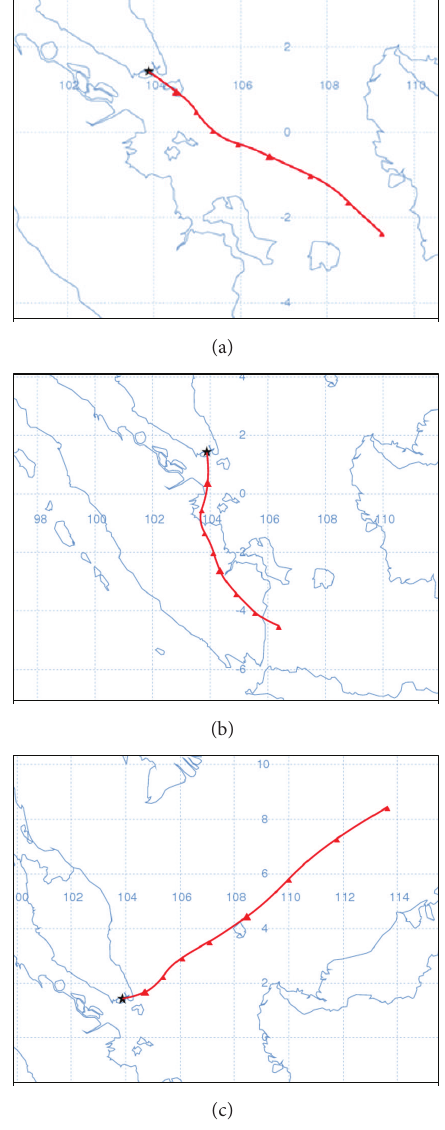
Figure 4: Representative days of backward air trajectories for three cases: (a) a prehazy day (14 June 1997); (b) a hazy day (29 August 1997); and (c) a posthazy day (05 December 1997).